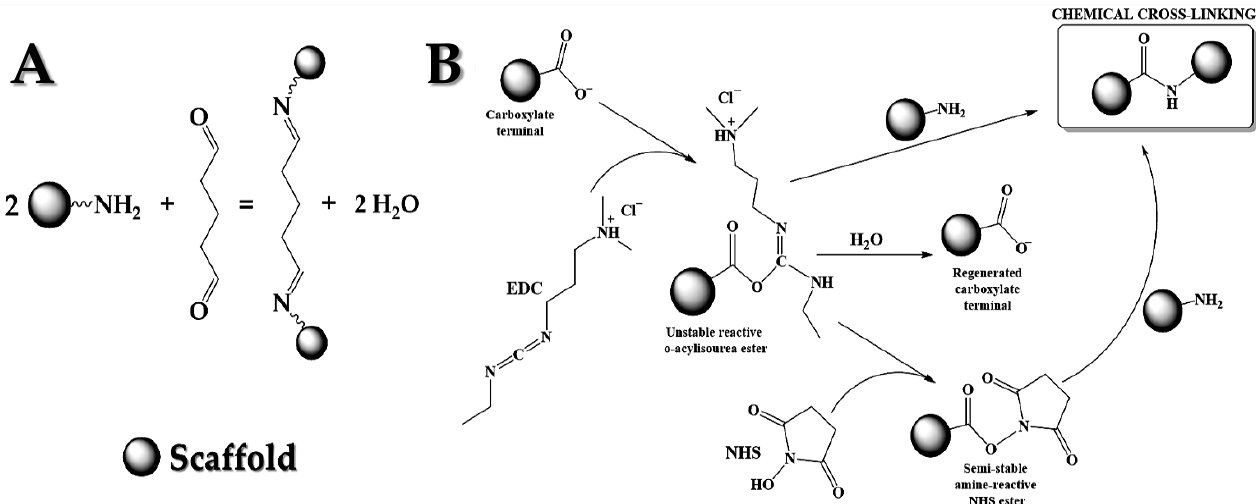
Figure 1. Representation of the crosslinking mechanism for the scaffold: ( A ) with glutaraldehyde for the formation of imine compounds as a result of crosslinking process; ( B ) with the EDC/NHS system for the formation of an amide bond, similar to amino acids in structure but more labile to interaction with the physiological medium.